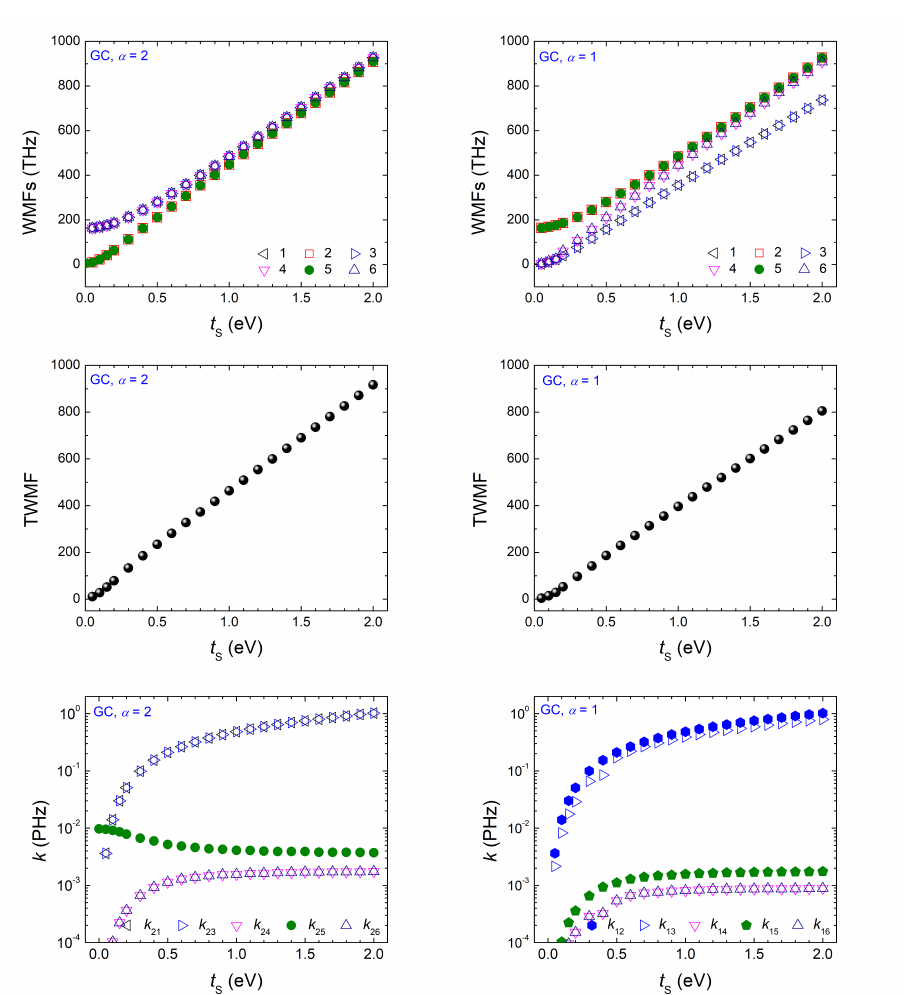
Figure A2. A dimer made of identical monomers and purine on pyrimidine: GC dimer. Initial oxidation occurs either at the first base pair ( α = 2, left column ) or at the first deoxyribose ( α = 1, right column ). The mean-over-time probabilities to find the hole at each dimer site (first row), WMFs of all sites (second row), TWMF (third row), and transfer rates from site to site are presented as functions of t S .